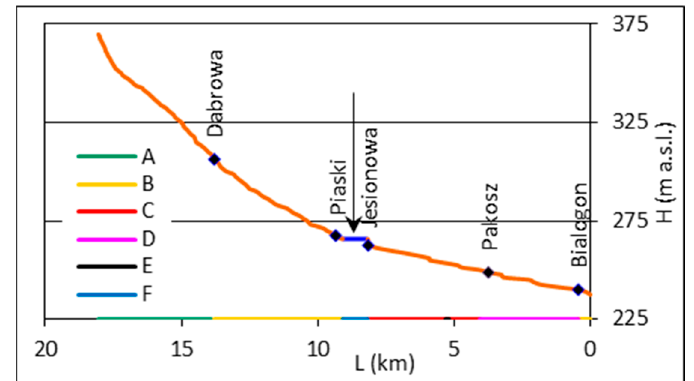
Figure 2. Locations of the hydrometric stations superimposed on the longitudinal profile of the Silnica river. River channel: A —natural or slightly modified; B —regulated (riverbanks reinforced with sod, fascine or rock ballast); C —regulated (riverbanks reinforced with concrete elements); D —regulated with substantial mid-channel deposits (riverbanks reinforced with sod, fascine or rock ballast); E —covered section; F —artificial reservoir; arrow—location of the artificial reservoir.